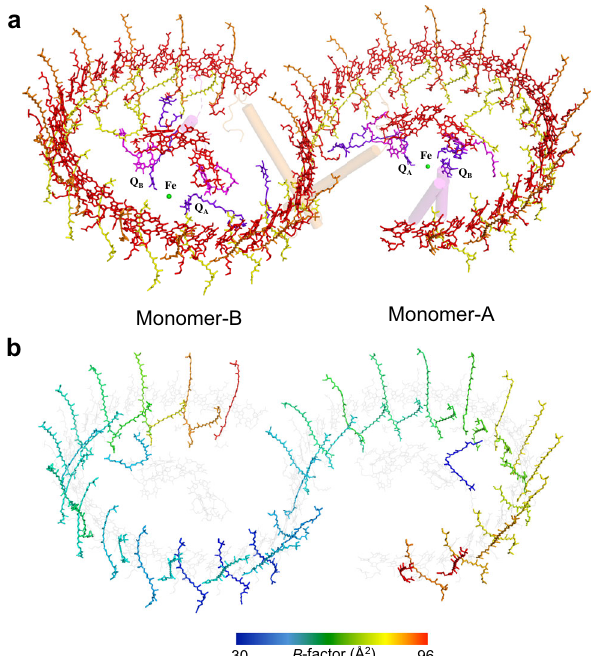
Fig. 2 Arrangement of the cofactors in the dimeric LH1 – RC complex. a Tilted view from the periplasmic side of the membrane with PufX (orange) and proteins-U (magenta) shown by transparent cylinders. Color scheme: BChl a , red sticks; spheroidenes (group A), yellow sticks; spheroidenes (group B), orange sticks; BPhe a , magenta sticks; UQ-10, purple sticks; nonheme Fe, green sphere. b B -factor distribution of the carotenoids in the core complex with colors representing the B -values indicated in the color bar. BChl a and BPhe a molecules are colored light